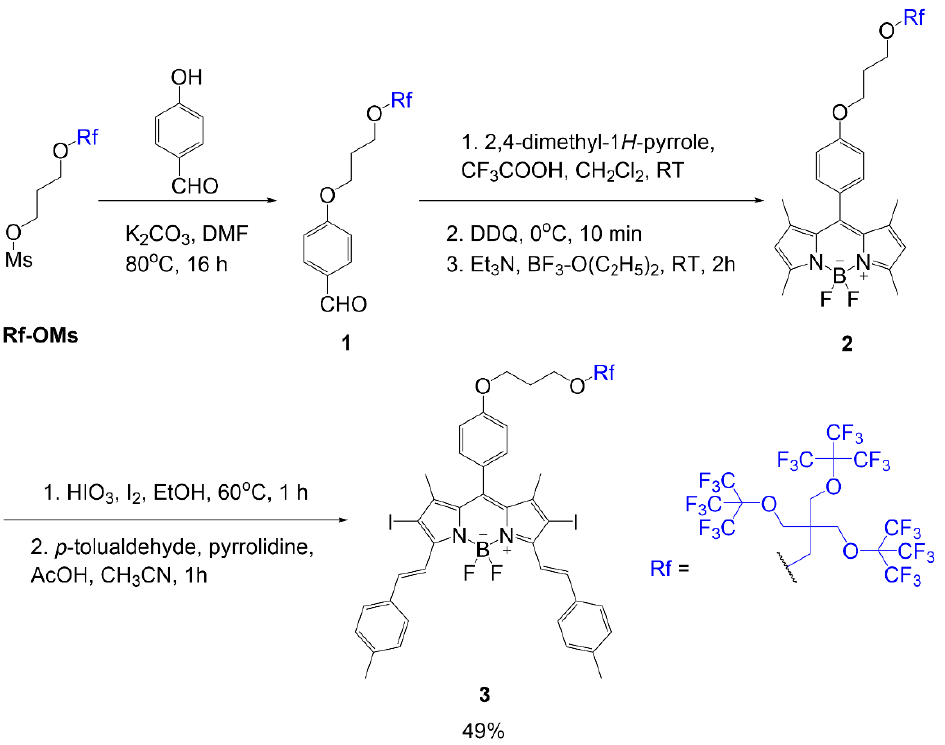
Figure 3. BODIPY with multi-branched fluorinated chains attached to boron center [21]. (1) In the next example, the aza-BODIPY 16 was synthesized as a trimodal contrast agent designed for fluorescence imaging, photoacoustic imaging, and 19 F MRI [35]. Of the listed modalities, the BODIPY core demonstrates extended conjugation for enhancing fluores- cence and photoacoustic imaging, and the trifluoromethyl groups on the aromatic ring are designed for 19 F MRI functionality. In Scheme 2, the synthesis of contrast agent 16 begins